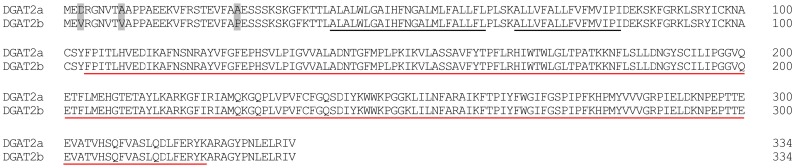
Comparison of the amino acid sequences of AhDGAT2a and AhDGAT2b.The three amino acid differences are shaded in gray. Two black underlined regions (amino acids 40–62 and 67–82) highlight the two predicted transmembrane domains. The red underline shows the conserved LPLAT_MGAT-like domain (amino acids 104–321).